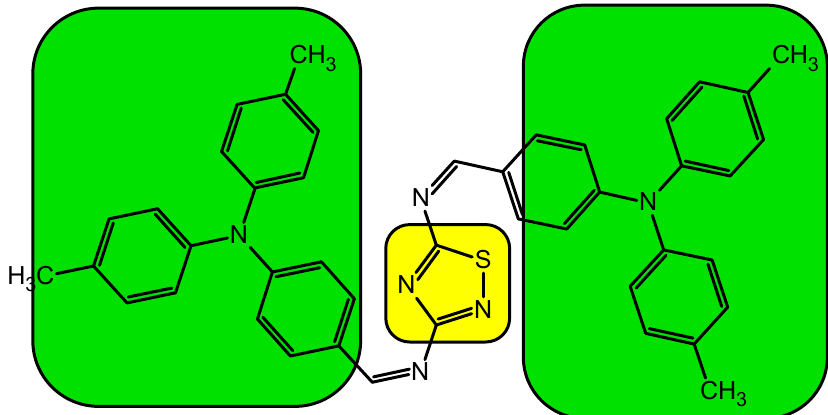
Figure 1. Chemical structure of the synthesized imine bTAThDaz.